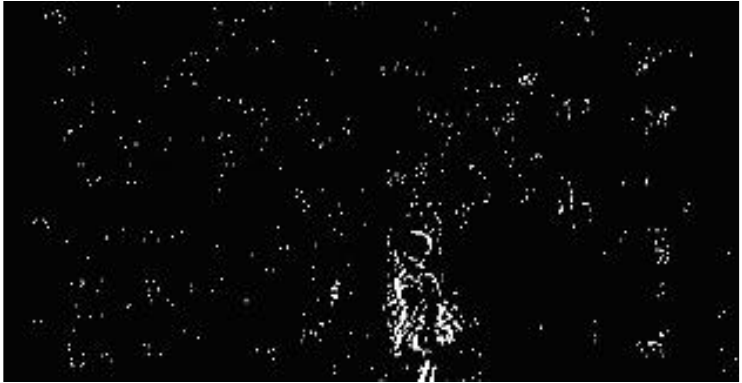
Figure 1. Object detection after background subtraction process with